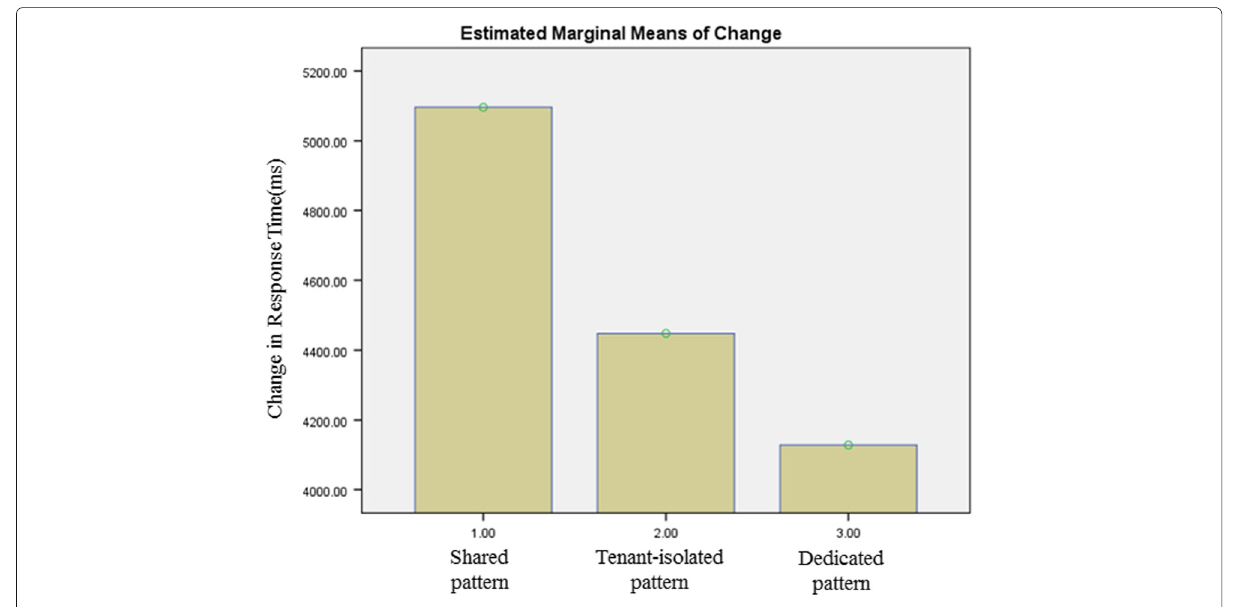
Fig. 15 Changes in Response Times [CS2]